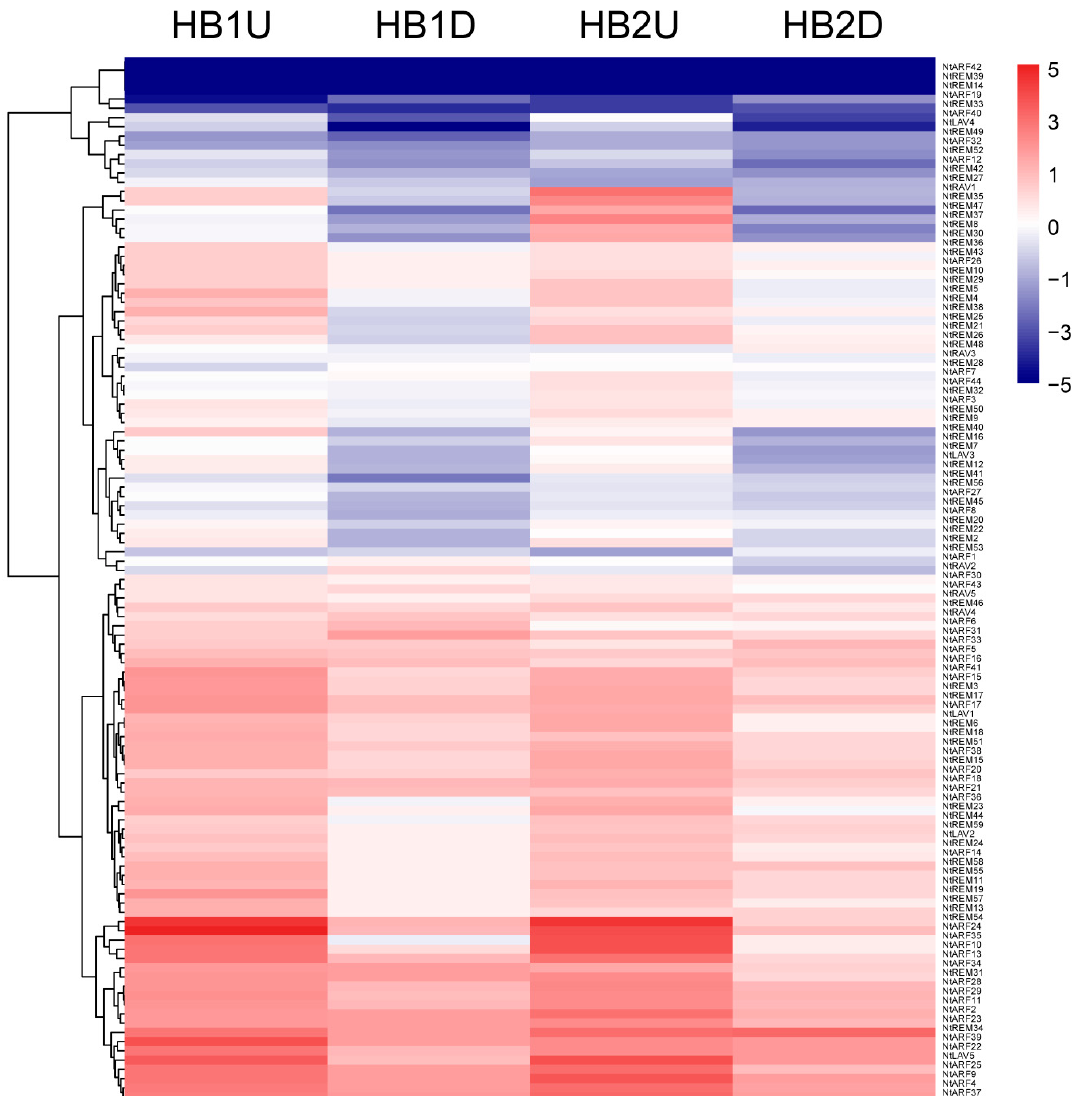
Figure 8. Expression pattern analysis of B3 genes in tobacco axillary buds in response to topping treatment based on qRT-PCR. HB1U and HB1D indicated the upper and lower axillary buds before topping, respectively. HB2U and HB2D indicated the upper and lower axillary buds after topping, respectively.